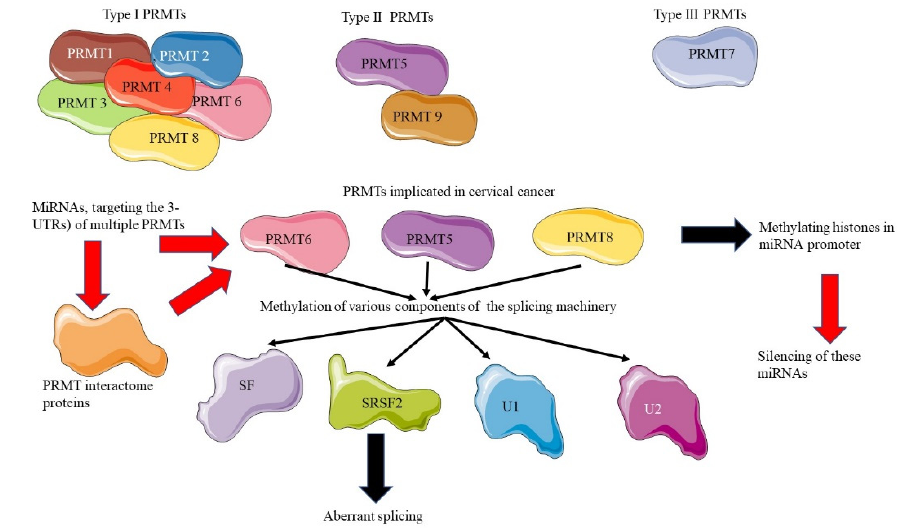
Figure 4. PMRT enzymes and alternative splicing. PRMTs regulate alternative splicing through the methylation of multiple components of the splicing machinery. The aberrant expression of PRMTs results in aberrant splicing, driving the development of cervical cancer. PRMT5, 6 and 8 are reportedly overexpressed in cervical cancer. A cross-regulatory relationship between miRNAs and PRMTs promotes cancer development and progression. miRNAs target the 3-UTRs of PRMTs for degradation, and PRMTs methylate histones in the miRNA promoter, leading to the silencing of